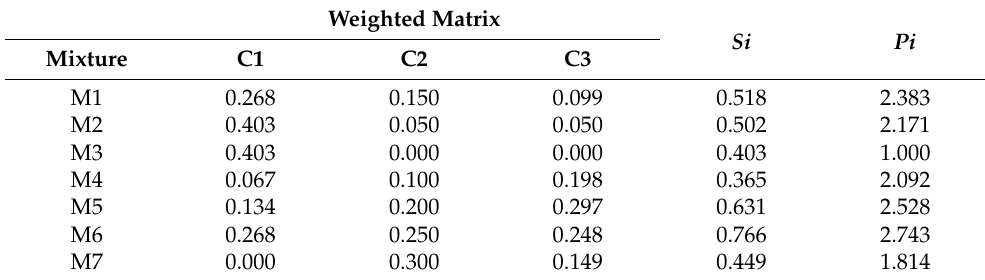
Table A4. Weighted normalized matrix and values for Si and Pi